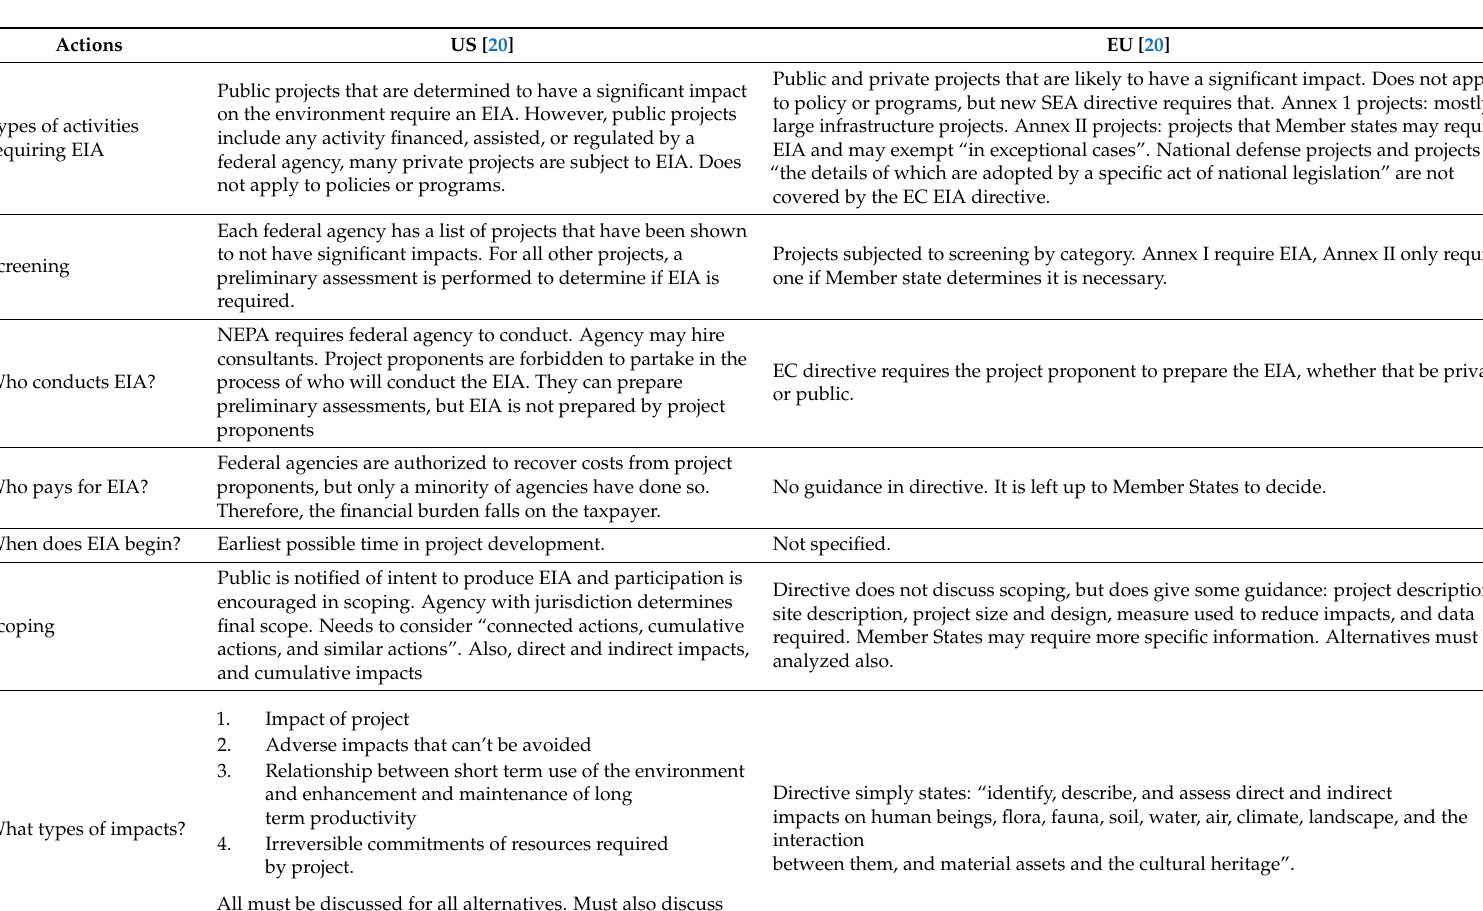
Table A1. Comparison of EIA practices in the US and the EU